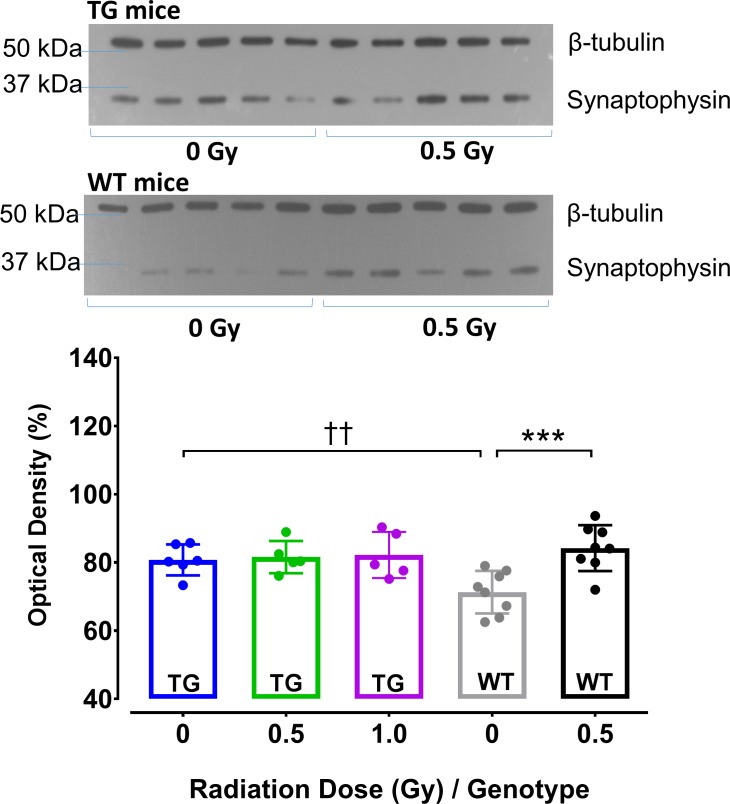
WB analyses of synaptophysin in the cortex of TG and WT mice 9 months post-irradiation.The average synaptophysin levels in TG control mice were significantly elevated when compared to WT controls. Irradiation of TG mice at 0.5 and 1 Gy had no effect on synaptophysin levels. In WT mice, irradiation significantly elevated synaptophysin to levels comparable to those observed in TG groups. Insets: Original images of WB gels prepared from TG (top panel) and WT (bottom panel) mice. Immuno-reactive bands optical densities indicate levels of synaptophysin (~38 kDa) and β-tubulin (~50 kDa) in cortical homogenates of control and irradiated 0.5 Gy mice. TG mice: N = 6, 5, 5 animals/radiation group; WT mice: N = 8, 8 animals/radiation group. Statistical analyses: 2-way ANOVA, Post hoc *** p<0.001 WT 0 Gy vs 0.5 Gy; †† p<0.01 WT vs TG controls. Data represent means ± SEM.